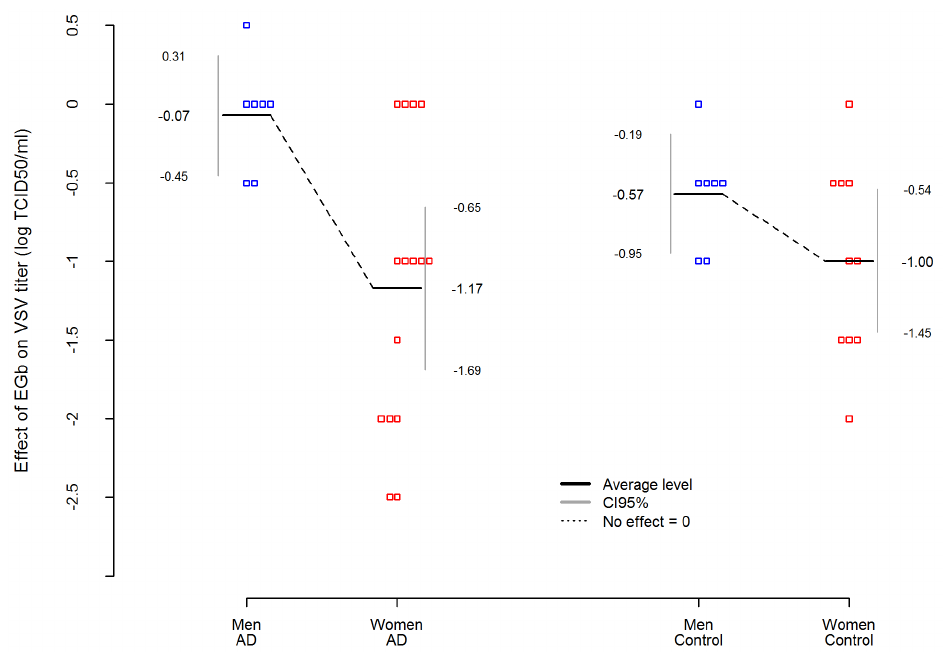
Figure 2. Sex-dependent differences in EGb effect on VSV replication/level of innate immunity in AD patients and healthy age-matched controls. EGb effect was measured as difference between VSV titer (log TCID50/mL) after EGb treatment and VSV titer (log TCID50/mL) before EGb treatment. Red and blue squares are individual observations.